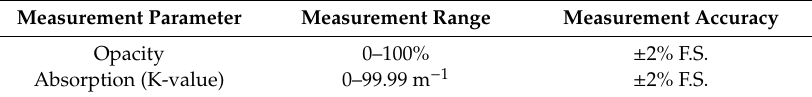
Table 5. Measurement range and resolution of MDO-2 LON analyser.